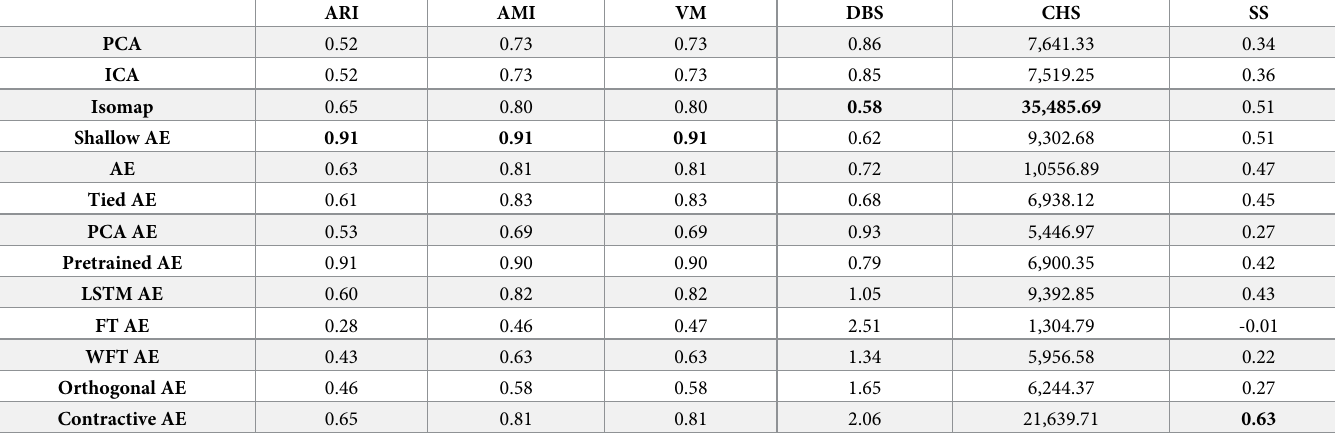
Table 7. Comparison of different autoencoder variations vs state-of-the-art methods on Sim16 (9 clusters), the optimal value of neighbours for Isomap was found as 20 through grid search. The metrics indicate that several variations of autoencoders and the Isomap algorithm are able to outperform conventional algorithms such as PCA or ICA for the Sim16 dataset that contains a moderate number of clusters. Moreover, two of autoencoder variants outperform Isomap with regard to the external met- rics implying that these variants offer more separable features for the clustering algorithm, the values indicating the highest performance for each metric have been bolded. ARI